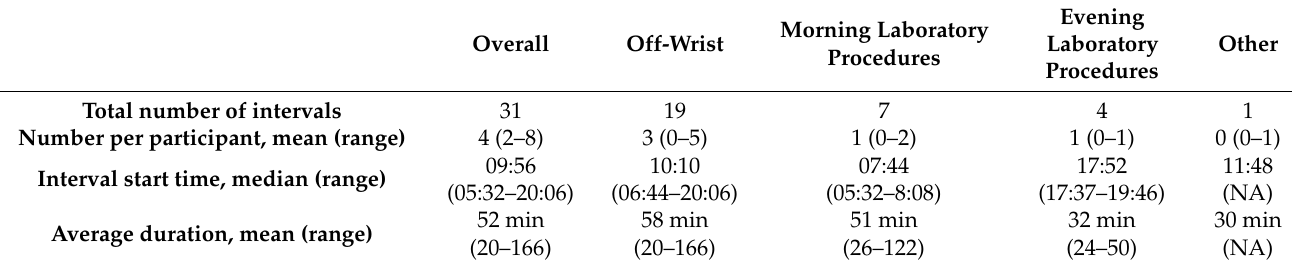
Table 5. Zulu watch extra sleep intervals by time, duration, and reason for occurrence. Overall Off-Wrist